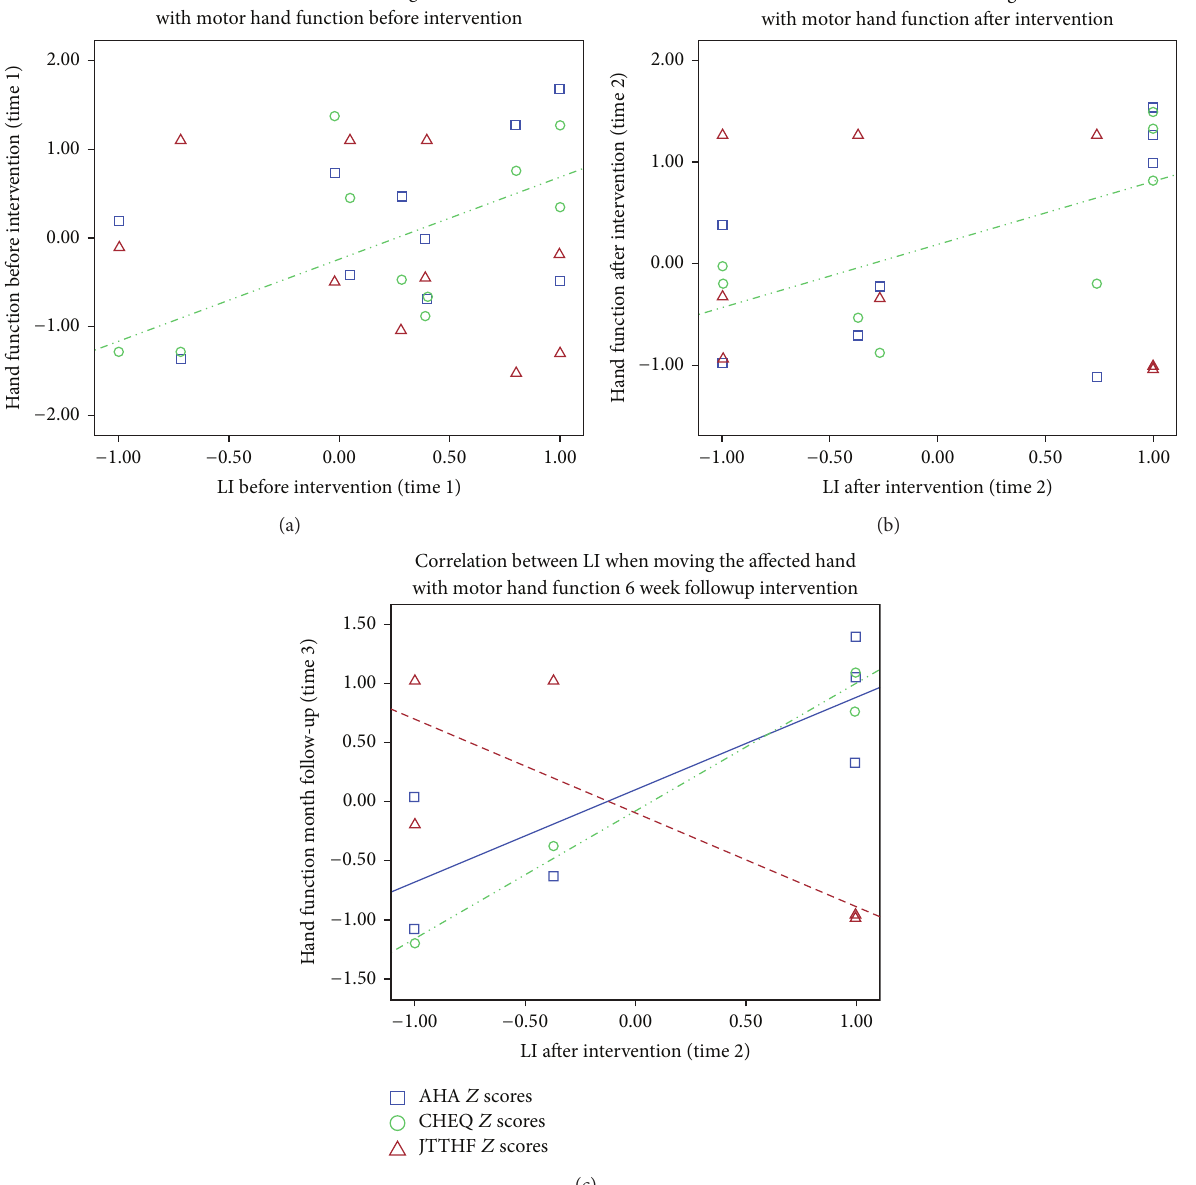
Figure 4: (a) Correlations between LI and manual function at (a) time 1: before intervention, (b) time 2: immediately after intervention, and (c) LI at time 2 and hand function at follow-up. 𝑌 -axis presents AHA, CHEQ, and JTTHF 𝑍 scores.